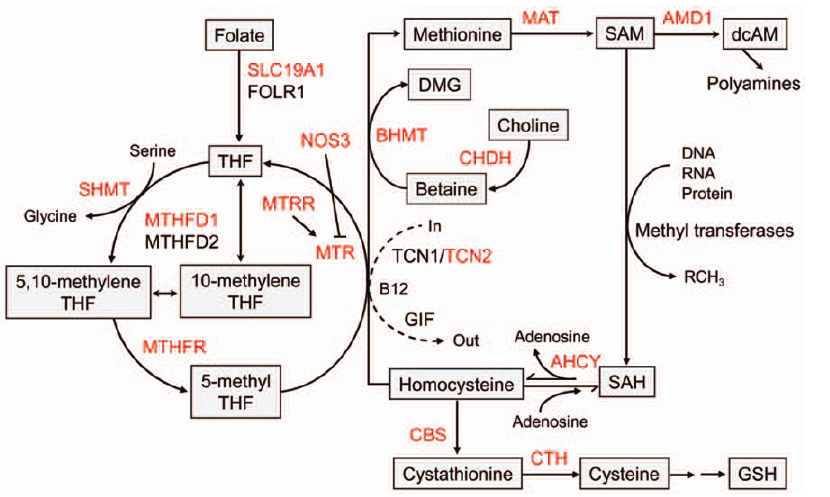
Figure 1. Homocysteine metabolism pathway. The genes selected for the study are marked in red fonts. Refer to Table 2 for gene names. Figure is adapted from Souto JC et al. (2005) Am J Hum Genet 76: 925–933 and Finkelstein JD (1998) Eur J Pediatr 157: S40–44.